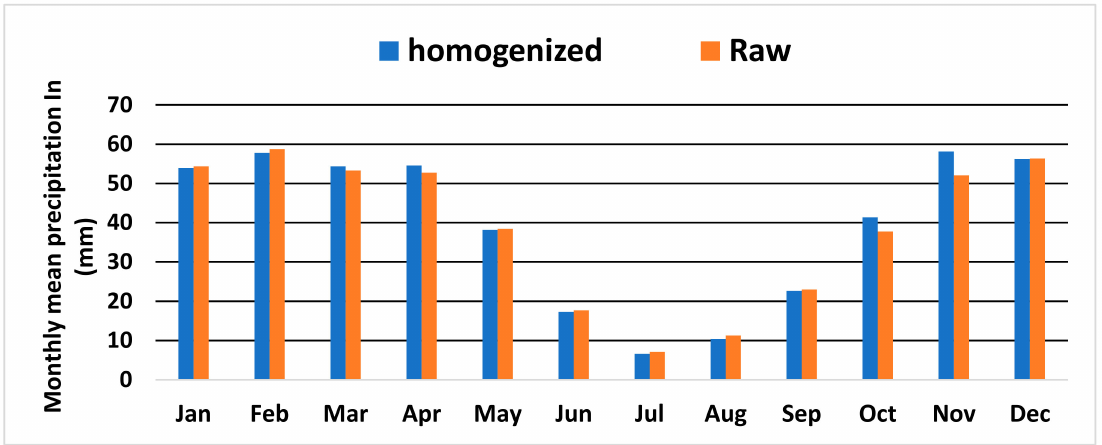
Figure 12. Monthly means of raw and homogenized data for the transition zone.